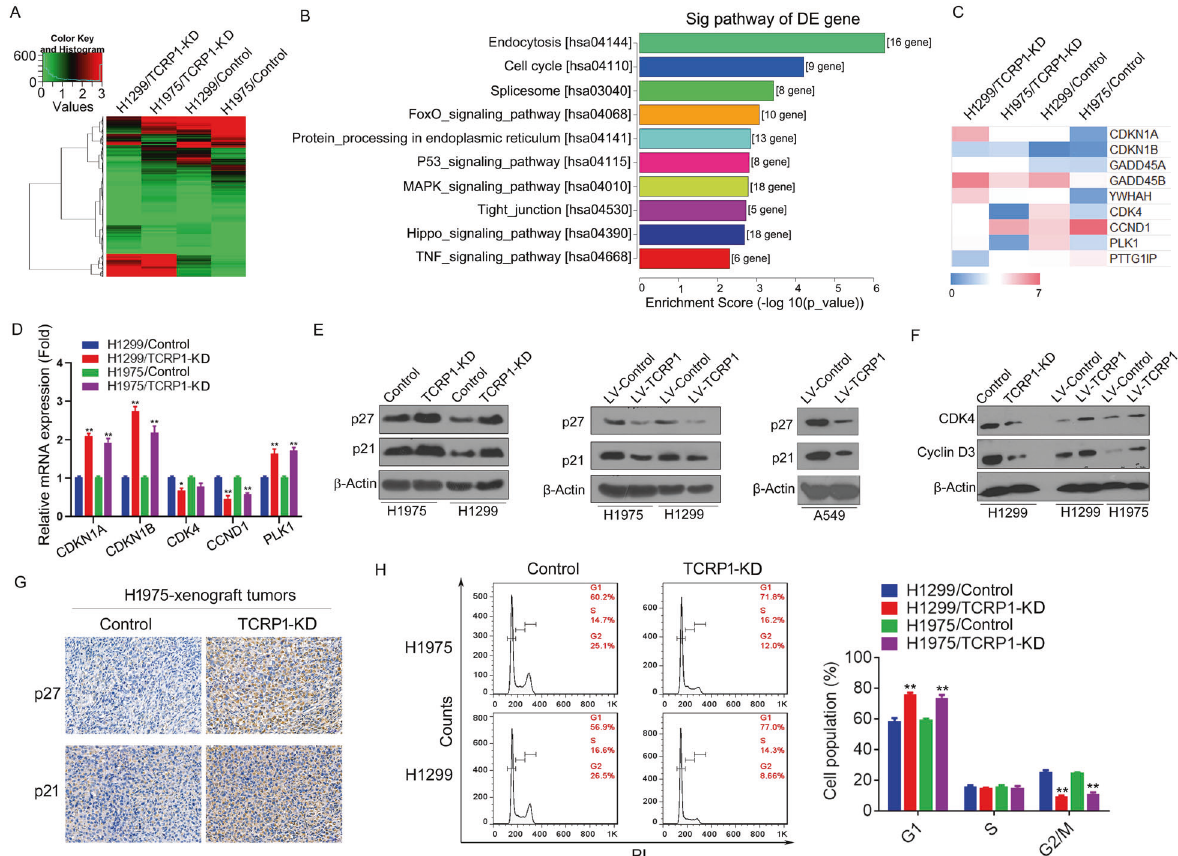
Fig. 4 TCRP1 advances cell cycles of NSCLC cells. A Total RNAs were collected from TCRP1-knockdown H1299 and H1975 cells, as well as their control cells, respectively. RNA-sequencing assays were performed in mentioned groups. B The differently expressed (DE) genes in above groups were analyzed by GO-KEGG analysis. C The potential DE genes related to cell cycles were exhibited. D The whole RNAs from mentioned cells were obtained. The expression levels of target genes were estimated via qRT-PCR assays, respectively. vs Control, * P < 0.05, ** P < 0.01. E TCRP1 was knocked down in H1299 and H1975 cells. Meanwhile, TCRP1 was overexpressed in H1299, H1975 and A549 cells. Western blot assays were performed to evaluate p21 and p27 protein expression in each group. F The protein levels of CKD4 and Cyclin D3